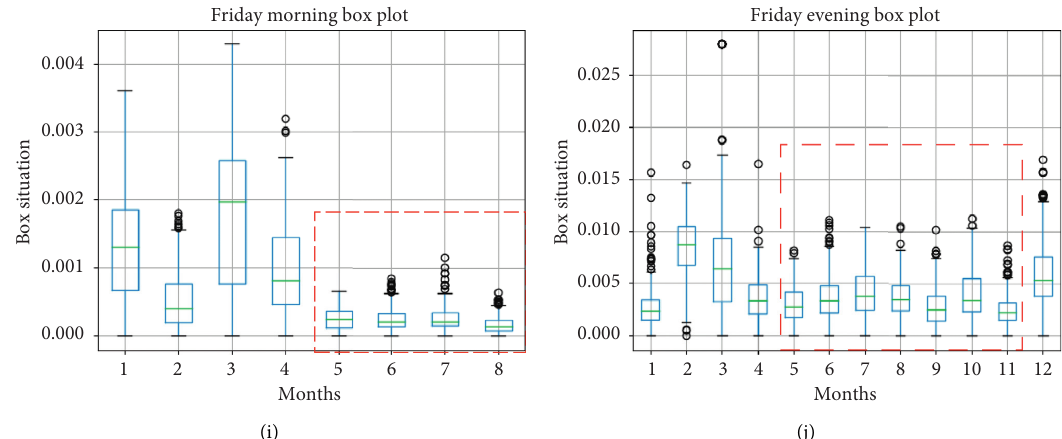
Figure 9: Box diagrams showing different distributions of vector distance in workdays in different months. The horizontal axis represents the months. The vertical axis represents the statistical status of vector distance: (a) distribution of distances in Monday morning peak, (b) distribution of distances in Monday evening peak, (c) distribution of distances in Tuesday morning peak, (d) distribution of distances in Tuesday evening peak, (e) distribution of distances in Wednesday morning peak, (f) distribution of distances in Wednesday evening peak, (g) distribution of distances in Thursday morning peak, (h) distribution of distances in Thursday evening peak, (i) distribution of distances in Friday morning peak, and (j) distribution of distances in Friday evening peak.